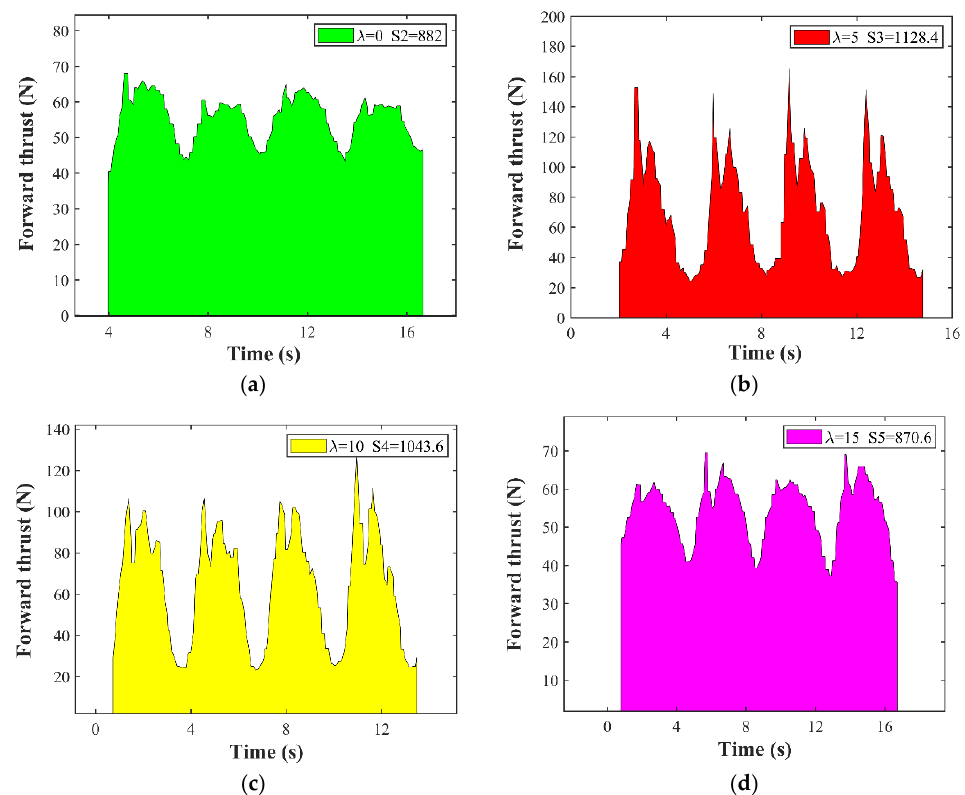
Figure 27. The integral area of the thrust of the SALL submerged glider in four random cycles. ( a ) The integral area at λ = 0°; ( b ) the integral area at λ = 5°; ( c ) the integral area at λ = 10°; and ( d ) the integral area at λ = 15°.